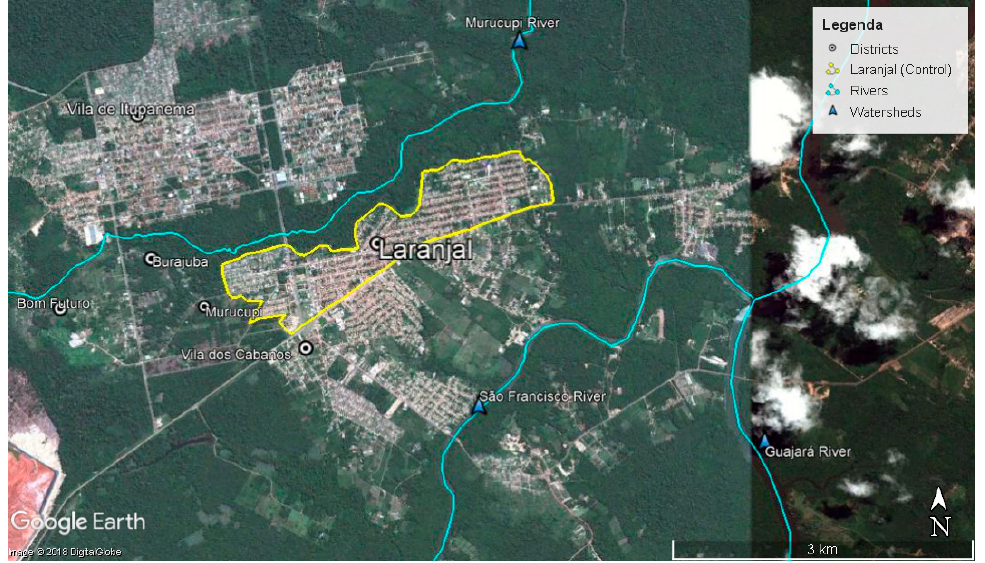
Figure A3. Location of the neighborhood of Laranjal (CLA), 2012. Source: Google Earth, 2017.